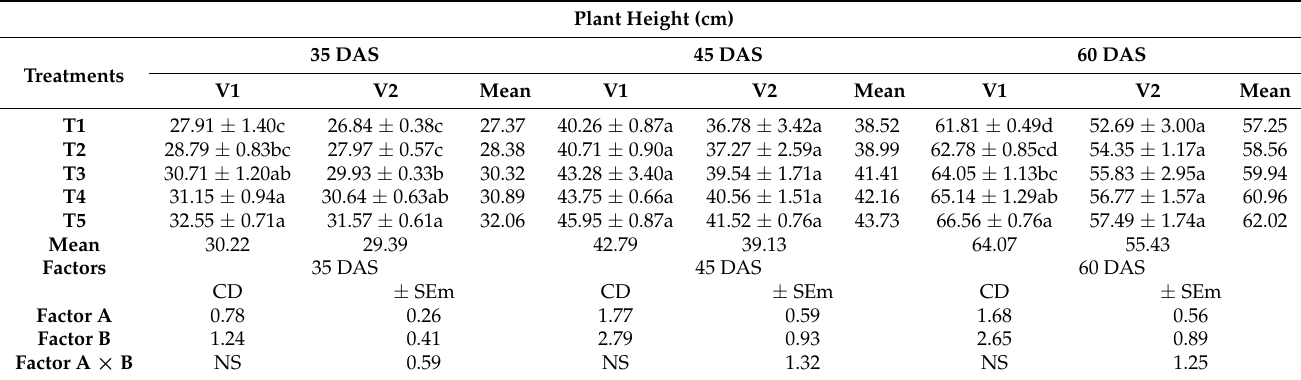
Table 4. Effect of hydro, Mg(NO 3 ) 2 , ZnSO 4 , Mg(NO 3 ) 2 + ZnSO 4 primed, and nonprimed (control) seed treatments on plant height (cm) of wheat varieties, grown in the year 2017–2018. Plant Height (cm)